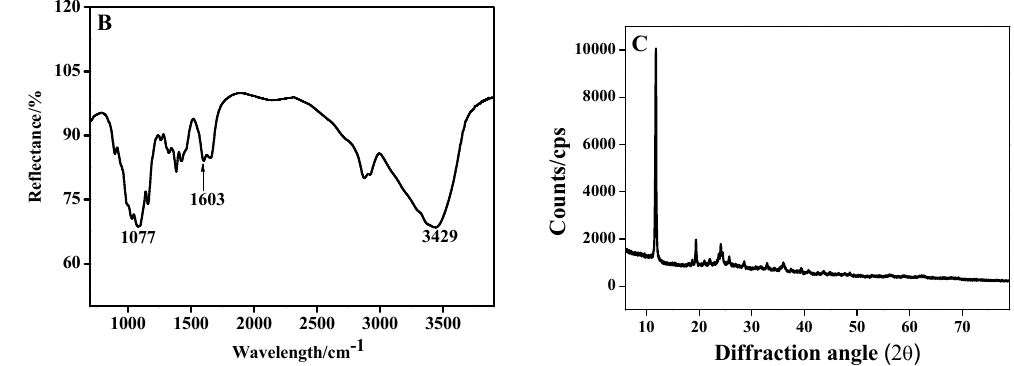
Figure 1. ( A ) Transmission electron microscope (TEM) image of chitosan ‐ Zn nanoparticles (NPs); ( B ) fourier transform infrared spectra (FTIR) spectra of chitosan ‐ Zn NPs; ( C ) X ‐ ray diffraction (XRD) spectra of chitosan ‐ Zn NPs.